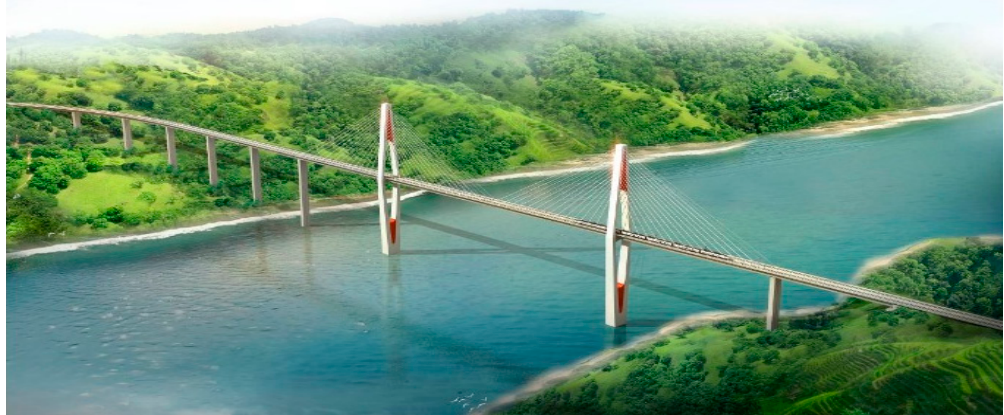
Figure 1. The Caijia Jialing River Bridge.